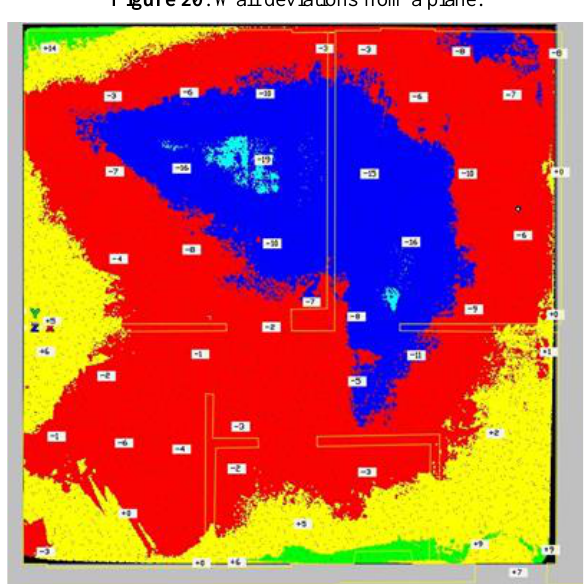
Figure 21 . Floor deviations from a plane.